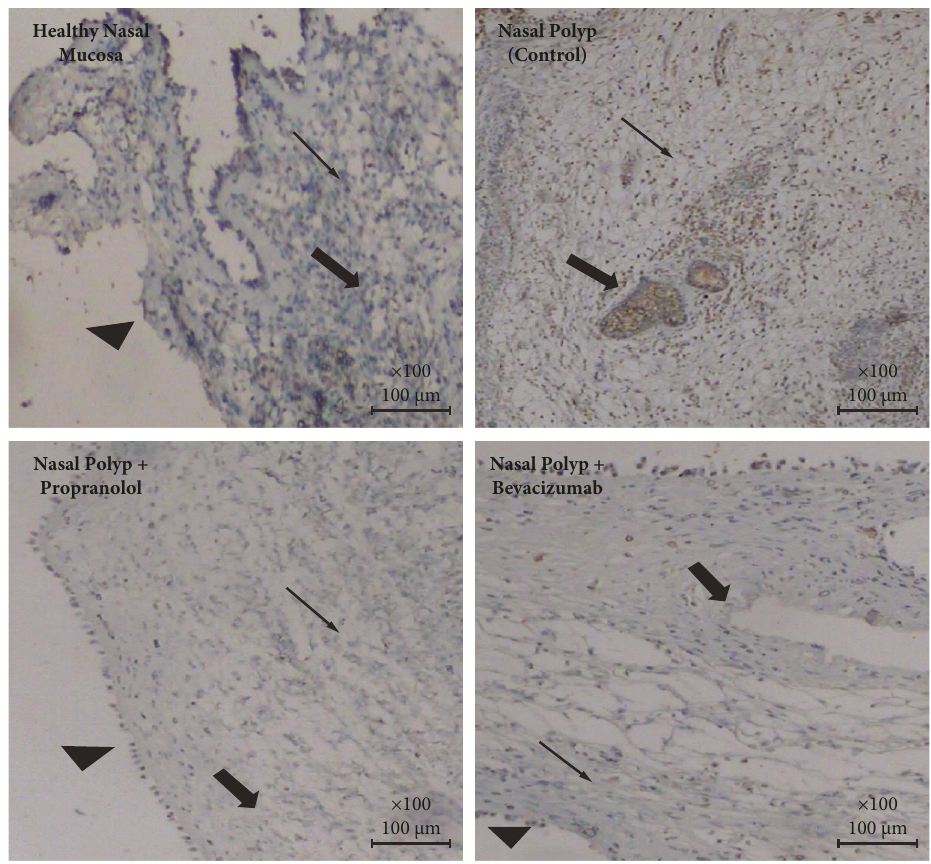
Figure 2: Ang-1 expressions on each group: A moderate expression is observed in nasal polyp group; this expression was absent in propranolol and bevacizumab group while it is low in normal mucosa (arrow head:mucosa, thick arrow: capillaries, thin arrow: intersisium (Ang-1, IHC,